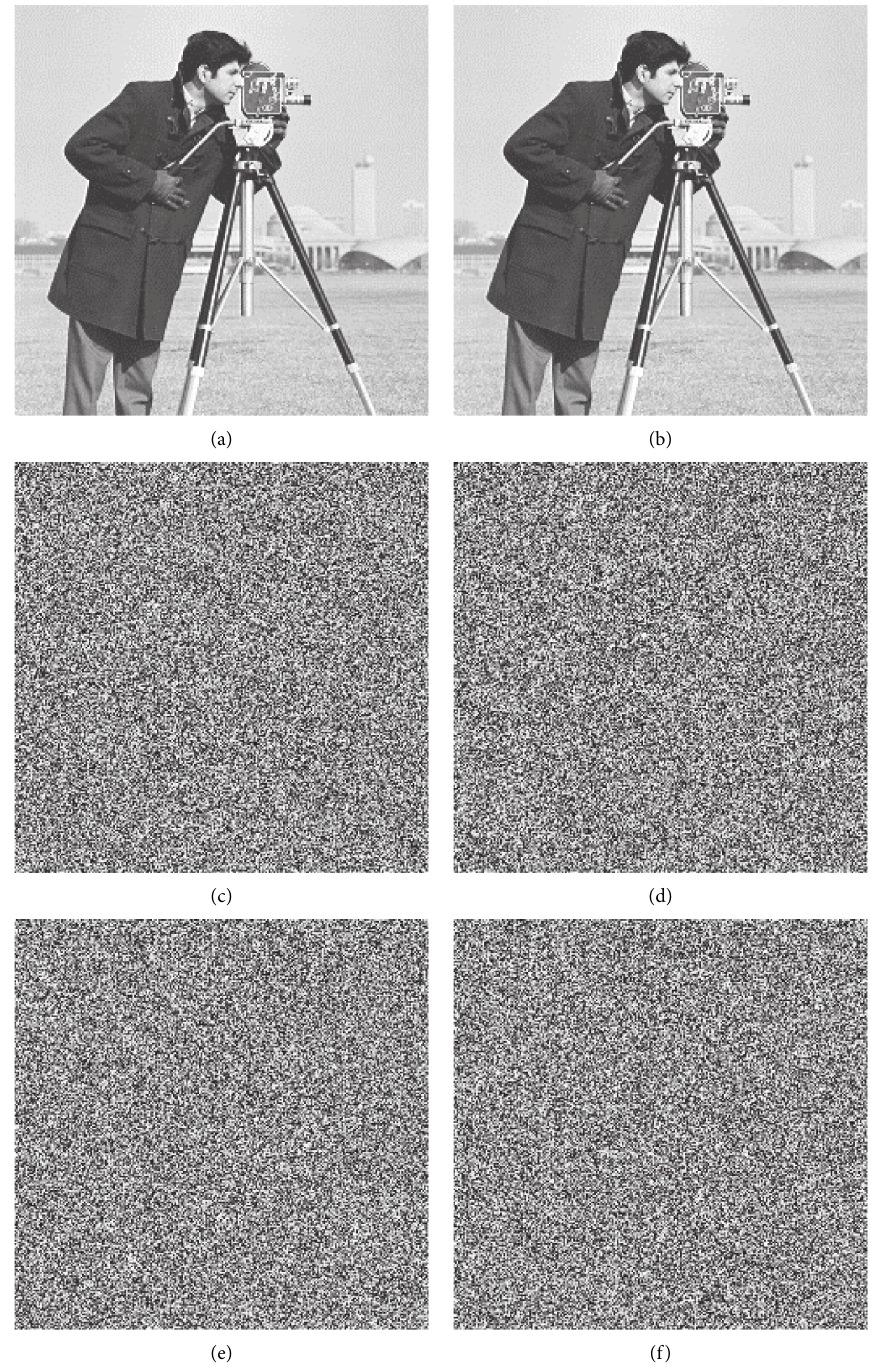
Figure 5: The plain cameraman image and decrypted images when the keys change slightly. (a) Plain cameraman image. (b) Correct decrypted image. (c) Decrypted image with x 1 +10 − 10 . (d) Decrypted image with y 1 +10 − 10 . (e) Decrypted image with z 1 +10 − 10 . (f) +10 − 10 Decrypted image with w 1